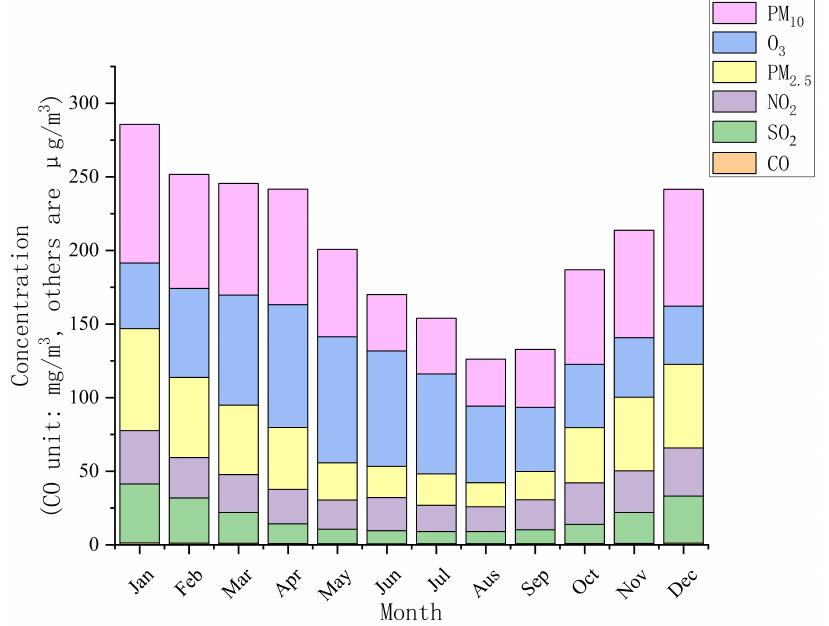
Figure 8. Monthly variation of six pollutant concentrations from 2015 to 2020 (CO unit: mg/m 3 , others are µ g/m 3